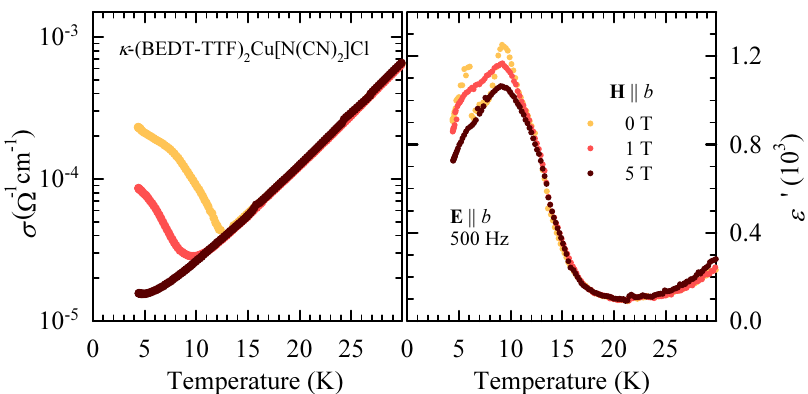
Figure 5. Magnetic field influence on sample S2 of κ -Cl. ( Left ) Conductivity σ measured at 500 Hz for E (cid:107) b versus temperature measured at different magnetic field strengths ( H (cid:107) b ). At H = 0T there is a rise in conductivity below 12K, while the application of magnetic field shifts the onset of conductivity rise to lower temperatures, thus indicating a superconducting phase transition at T SC ≈ 12K. ( Right ) Real part of the dielectric function ε (cid:48) as a function of temperature with the ac electric field applied E (cid:107) b , and measured at different magnetic field strengths ( H (cid:107) b ). The effect of the magnetic field can be seen only below 12K. Increasing magnetic field lowers the peak amplitude.